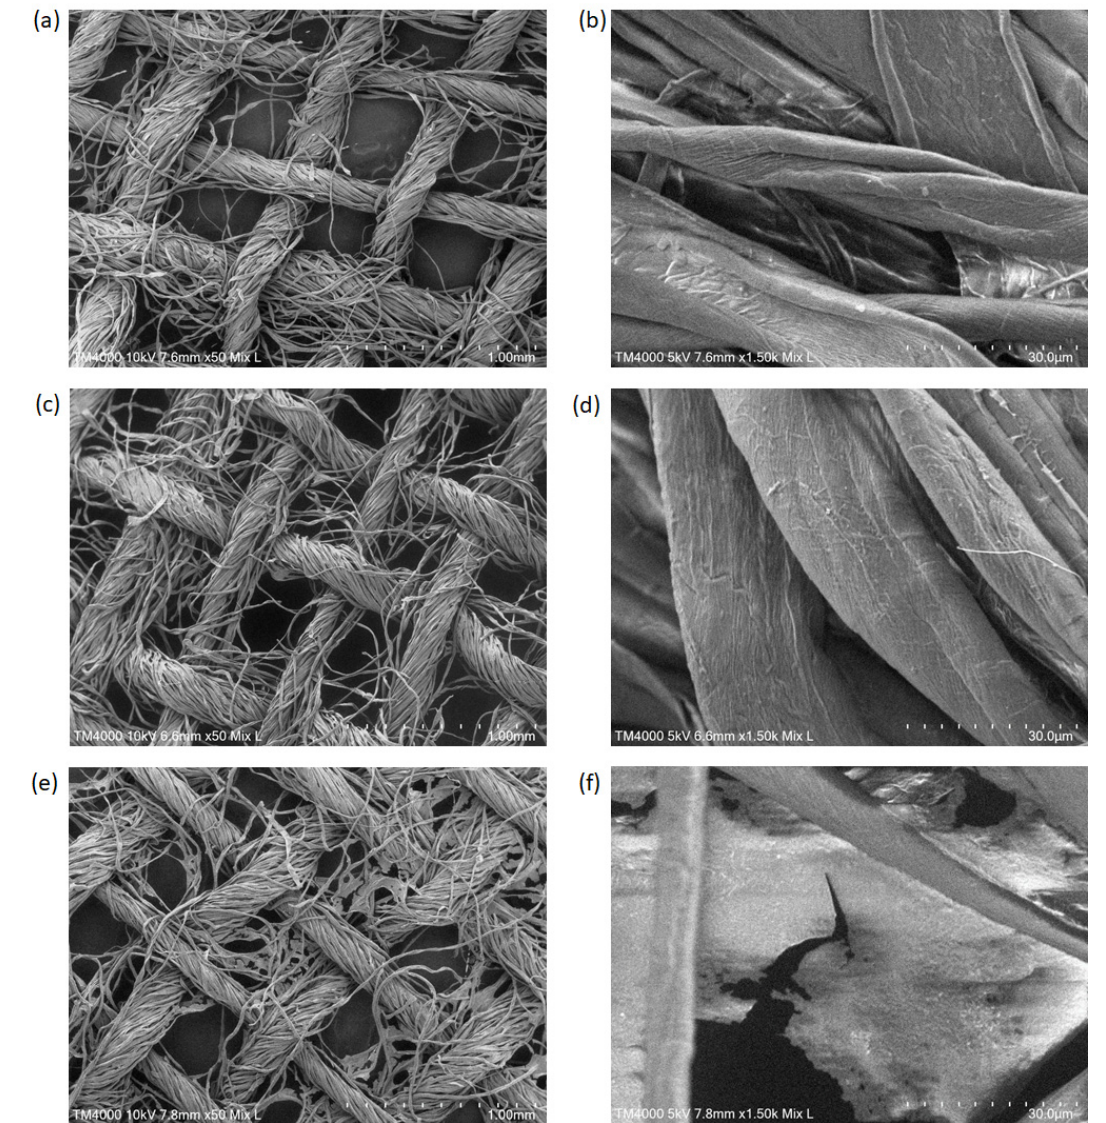
Figure 3. SEM images of ( a , b ) crosslinked chitosan coating no-enzyme control, ( c , d ) surface covalently immobilized NZCA mono-layer, and ( e , f ) surface covalently immobilized NZCA 3-D aggregate, all on cheesecloth support materials.